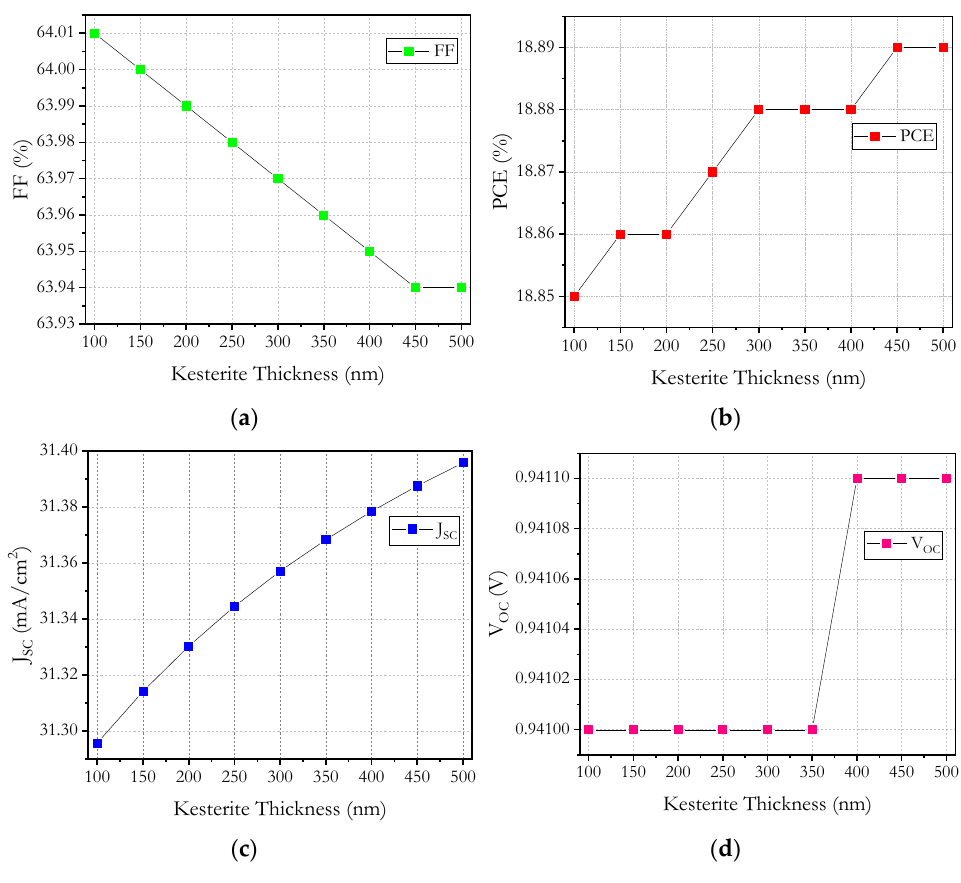
Figure 8. Kesterite layer thickness versus: ( a ) FF , ( b ) PCE , ( c ) J sc and ( d ) V oc .